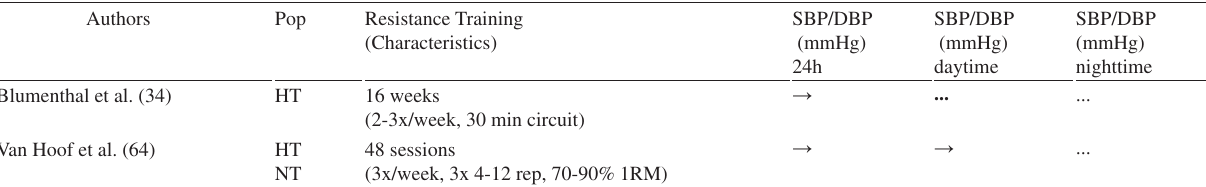
Table 4 - Effects of resistance training on ambulatory blood pressure